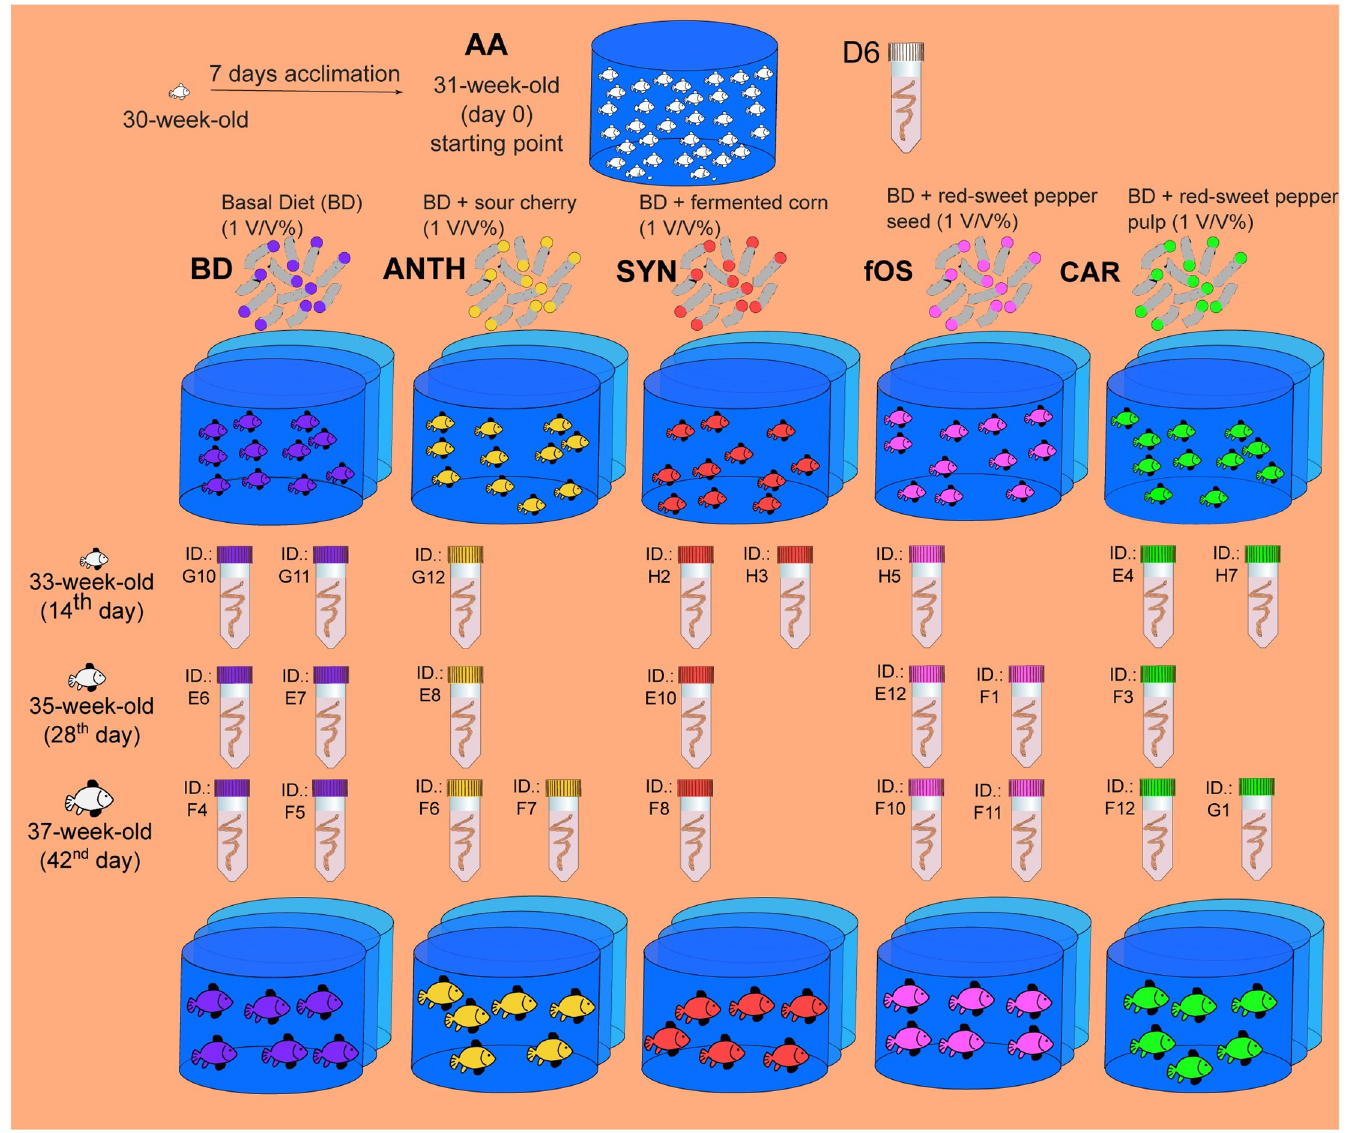
Fig 1. Overview of the study protocol showing the feeding and sampling strategies. AA stands for acclimatized animals aged 7 months (30 weeks). The fish were divided randomly into five experimental groups and fed either the commercial basal diet (BD, negative control) with no dietary supplement or the following dietary treatments as supplemented feed: BD+1% anthocyanins (ANTH) provided by Hungarian sour cherry extract, BD+1% synbiotics (SYN) provided by fermented corn, BD +1% fermentable oligosaccharides (fOS) provided by Hungarian sweet red pepper seed extract, and BD+1% carotenoids (CAR) provided by Hungarian sweet red pepper pulp extract. The fish intestines were collected on the 1 st , 14 th , 28 th and 42 nd days of the experimental period. The letter and number codes (D6-H7) refer to the code used during the 16S metagenomic sequencing library